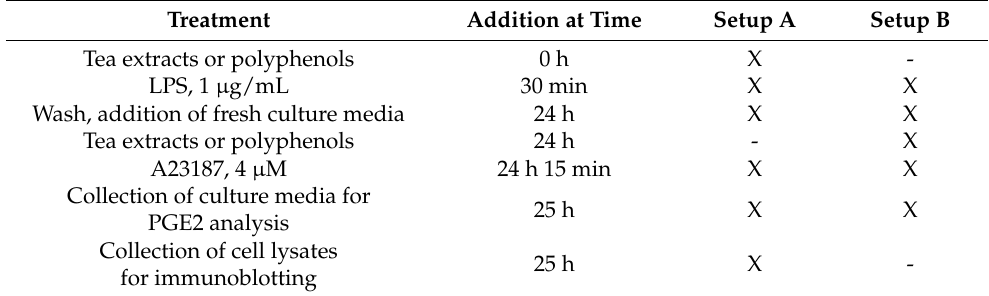
Table 1. Flowchart for the experimental setups used for the assessment of PGE2 formation in human monocytes when treated with tea extracts, EGCG or quercetin. The only difference between the two experimental setups is the indicated timing of treatment with tea extracts or polyphenols. Treatment Addition at Time Setup A Setup B Tea extracts or polyphenols 0 h X